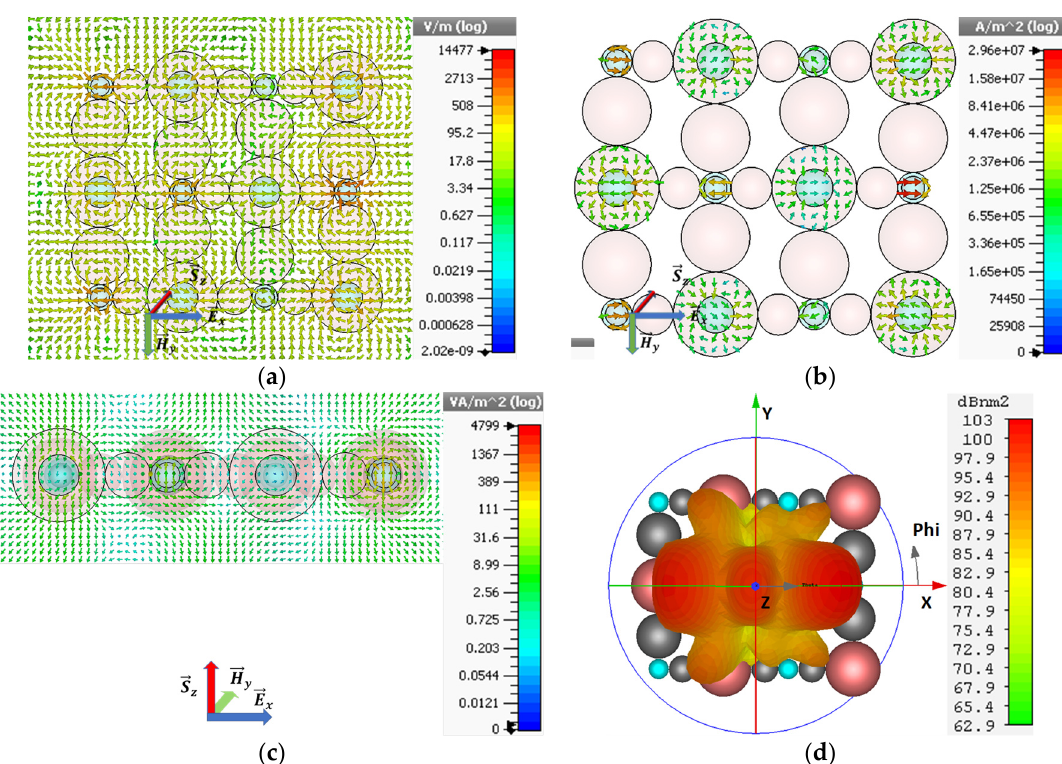
Figure 8. ( a ) Electric field spectrum, ( b ) current density, ( c ) power flow and ( d ) far-field pattern at the resonance frequency, respectively, for extended array model.